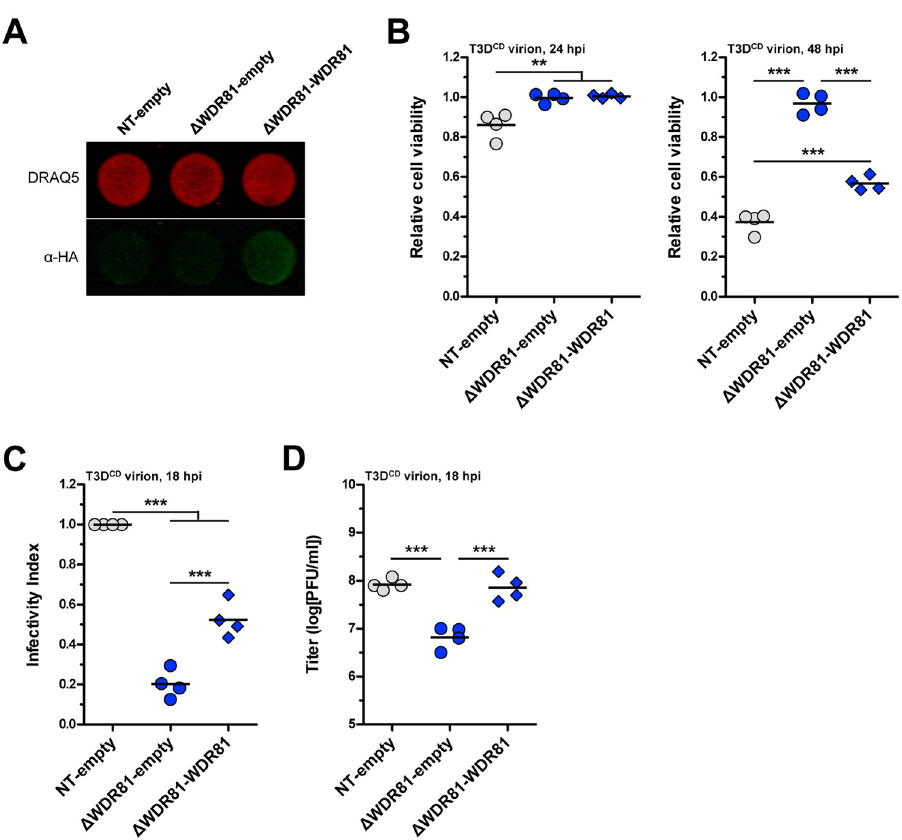
Fig 4. Complementation of WDR81-deficient cells. (A) WDR81 complementing cell lines. The levels of 2xHA-WDR81 in each cell line were determined by indirect immunofluorescence. The DRAQ5 (total cells) signal is false colored in red, and the IRDye 800CW (2xHA-WDR81) is false colored in green (n = 4 biological replicates; results for 1 representative experiment are shown). (B) Induction of cell death. NT-empty, Δ WDR81-empty, and Δ WDR81-WDR81 cells were infected with T3D CD virions at 5 PFUs/cell. At 24 and 48 h post infection (hpi), the relative cell viability was measured using the CellTiter-Glo Luminescent Cell Viability Assay. Horizontal bars indicate the means; �� , P � 0.005, ��� , P � 0.0005 (n = 4 biological replicates). (C) Levels of infectivity. NT-empty, Δ WDR81-empty, and Δ WDR81-WDR81 cells were infected with T3D CD virions at 5 PFUs/cell. At 18 hpi, the infectivity index was measured using indirect immunofluorescence. Horizontal bars indicate the means; ��� , P � 0.0005 (n = 4 biological replicates). (D) Production of infectious virus. NT-empty, Δ WDR81-empty, and Δ WDR81-WDR81 cells were infected with T3D CD virions at 5 PFUs/cell. At 18 hpi, the amount of infectious virus produced was measured using plaque assay. Horizontal bars indicate the means; ��� , P � 0.0005 (n = 4 biological replicates).